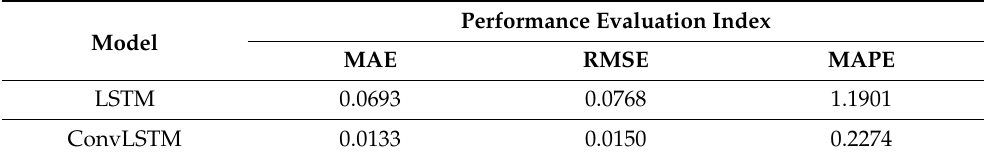
Table 5. Comparison of node prediction results of IEEE-118 bus